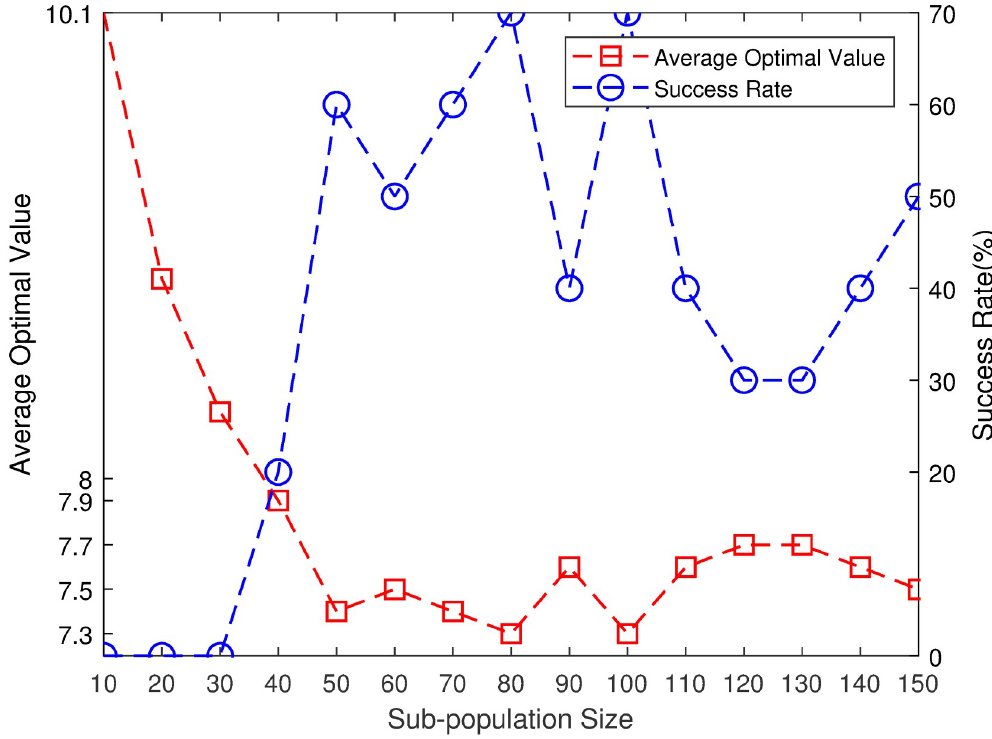
Fig 5. Effect of sub-population size on MPGA-ER.